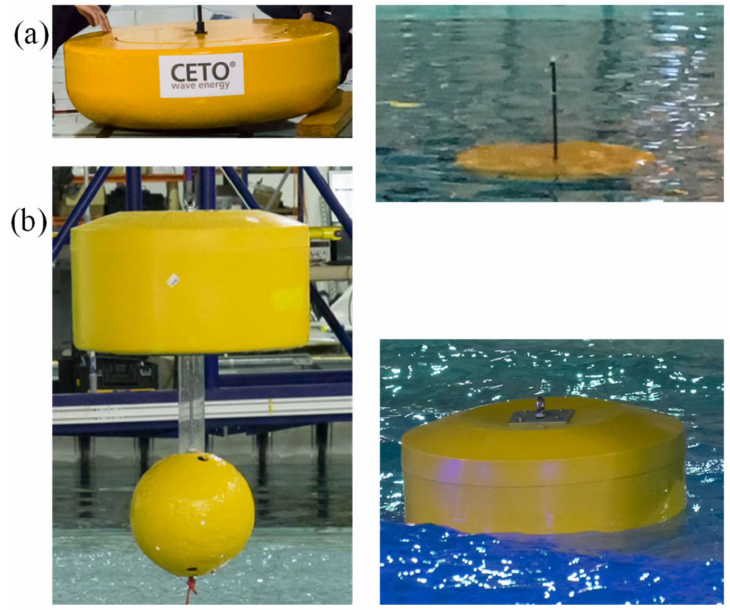
Figure 11. The two heaving buoys used for testing ( a ) is a fully submerged buoy, and a scale model of the CETO device [9] ( b ) is a surface piercing buoy.